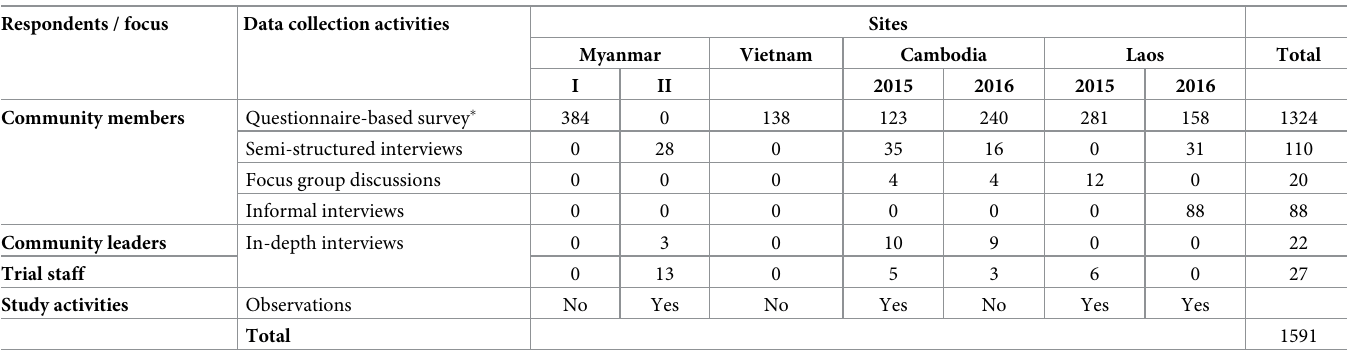
Table 3. Data collection methods across various TME sites in the